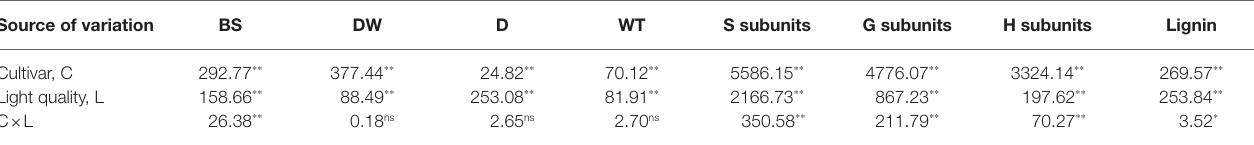
F-values were shown. C, cultivar; L, quality; BS, breaking strength; DW, dry weight per length; D, diameter; WT, wall thickness; S, syringyl lignin; G, guajacyl lignin; H, p-hydroxyphenyl lignin; and Lignin, lignin content.